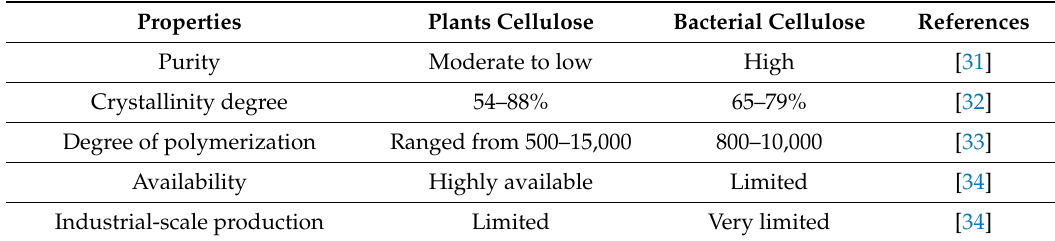
Table 1. Di ff erences between plants and bacterial